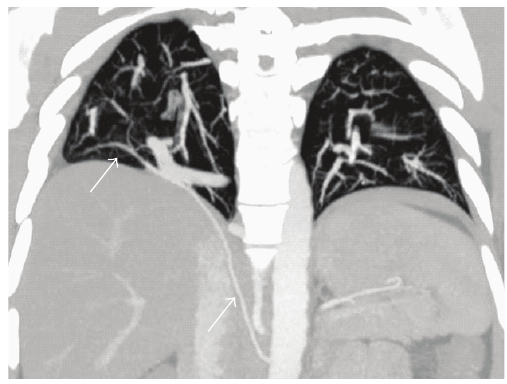
Figure 6: CT angiography maximum intensity projection image in coronal plane depicts anomalous arterial supply (arrow) to the normal lung tissue contiguous with sequestration.